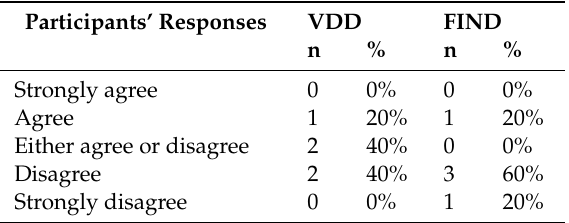
Table 13. Participants’ opinions about the spatial metadata related to their requirements for assessing suitability of spatial data.